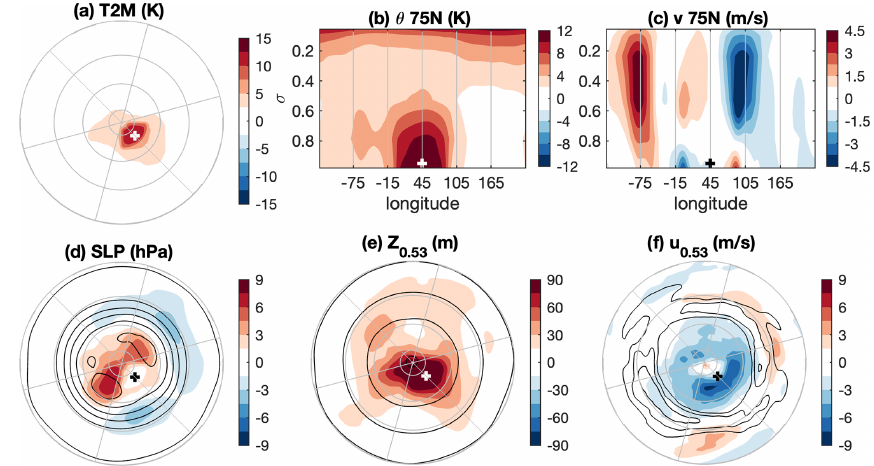
Figure 10. The response of an idealised GCM to localised heating at high latitudes. Contour lines in panels (d) – (f) indicate the mean state, with contour intervals of (d) 5hPa, (e) 200m, and (f) 1ms − 1 . A cross marks the location of the imposed